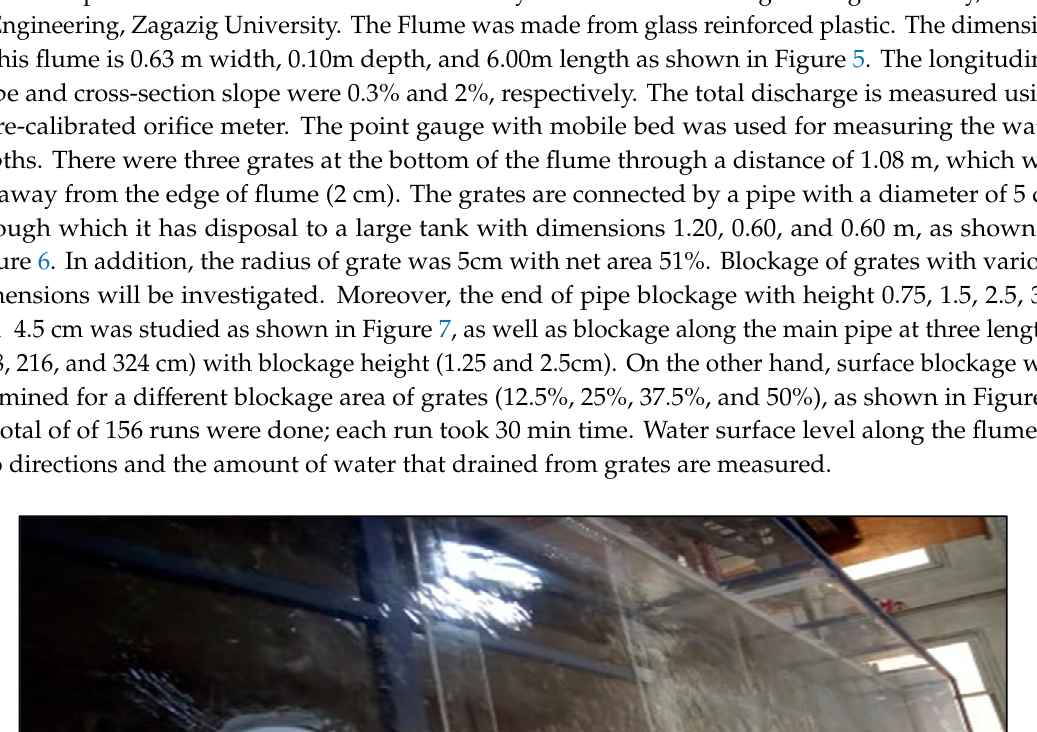
Figure 4. Definition sketch for blockage through pipe and grate.